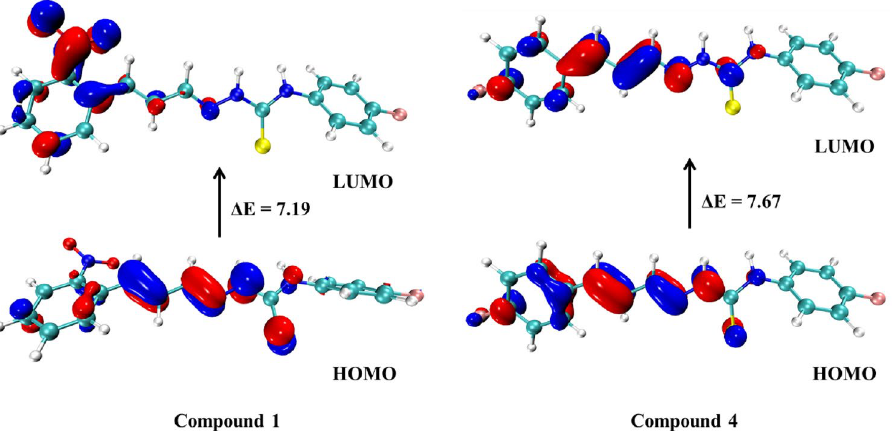
Figure 11. HOMO and LUMO orbitals surfaces of compound 1 (left) and compound 4 (right) with their respective ΔE HOMO-LUMO (eV).